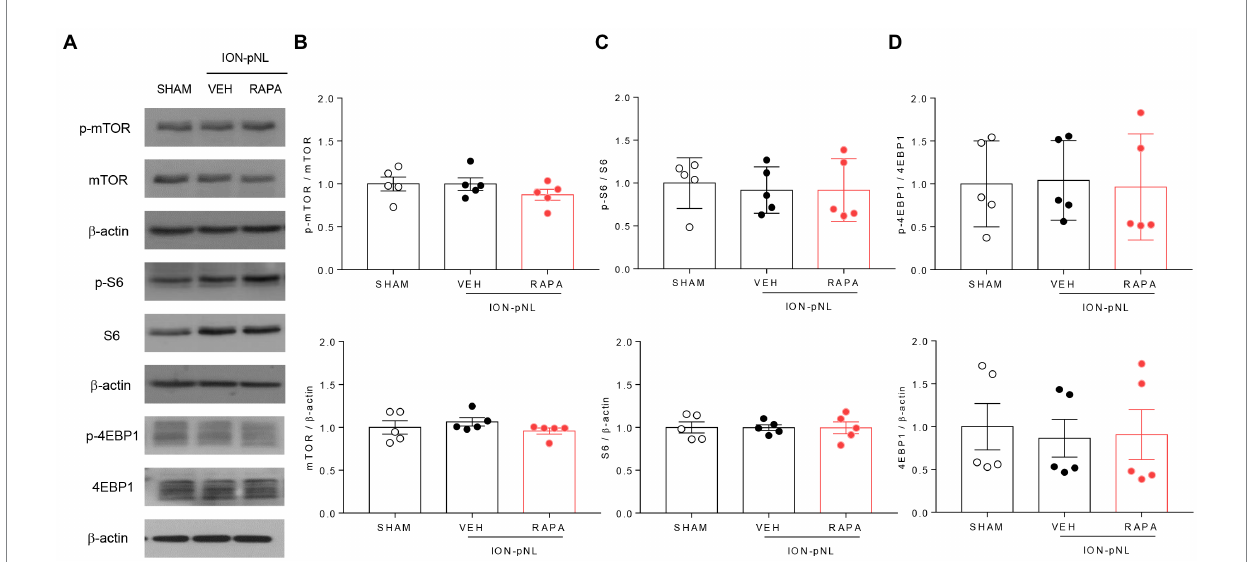
FIGURE 3 Expression of mTOR signaling-related proteins in the trigeminal nucleus caudalis (TNC). mTOR, S6, 4EBP1, and their phosphorylated forms (p-mTOR, p-S6, and p-4EBP1) were all unchanged in the ION-pNL group compared with the SHAM group (A–D) . High-dose rapamycin treatment (RAPA) produced no significant change in the expression of each protein (A–D) compared with the VEH group, n = 5 per group.